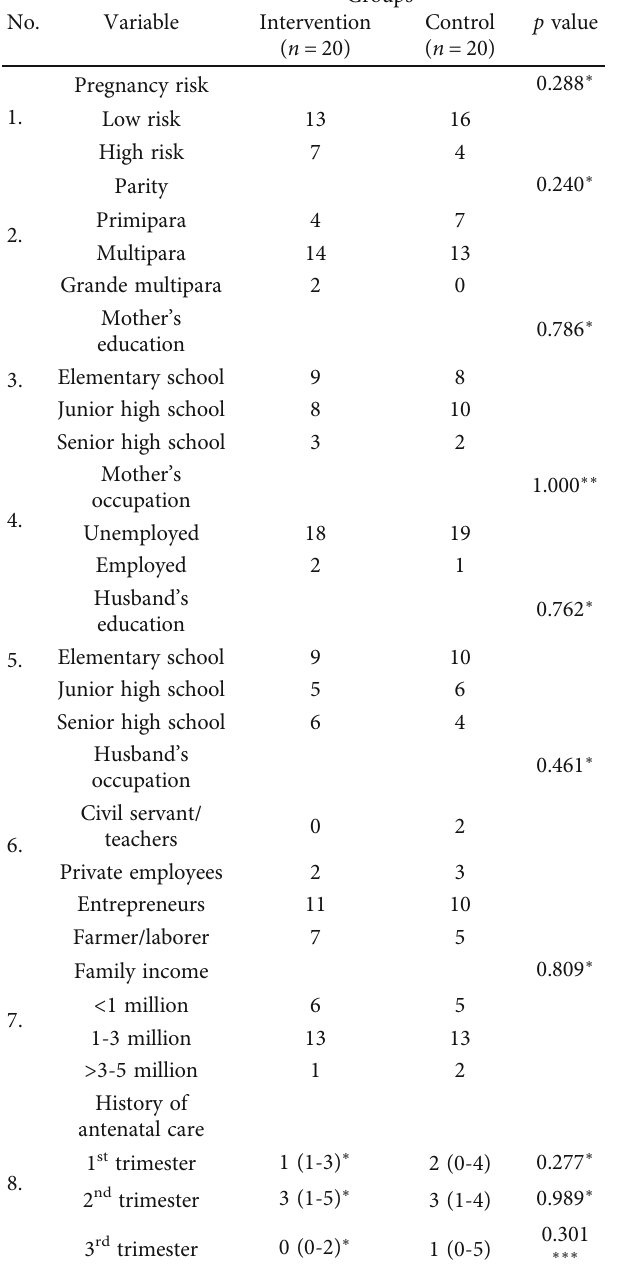
Table 3: Comparison of anthropometric measurements in both